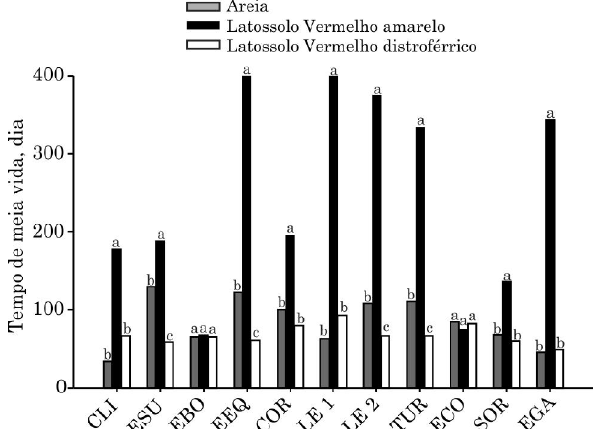
Figura 3. Tempo de meia-vida dos resíduos orgânicos incubados por 270 dias de incubação, em misturas com areia e de Latossolo Vermelho-Amarelo e de Latossolo Vermelho distroférrico. LE 1: lodo de esgoto 1; LE 2: lodo de esgoto 2; EGA: esterco de galinha; CLI: composto de lixo; COR: composto orgânico; substrato orgânico; TUR: turfa; EEQ: esterco de equino. Médias de tempos de meia-vida do N mineralizado em Latossolos e em areia, dentro de cada resíduo orgânico, seguidas pela mesma letra não diferem entre si pelo teste de Skott- Knott a 5